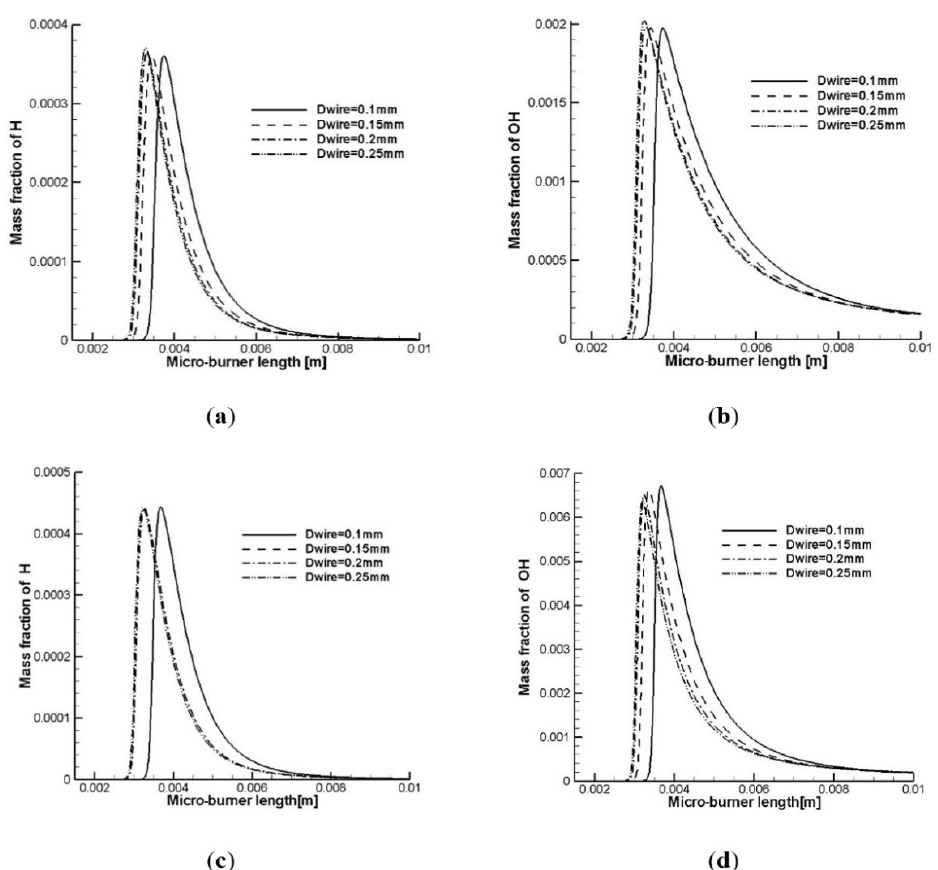
Figure 5. Flux analysis of methane consumption (20%) at three different temperatures corresponding to the axial distance where CH 3 mass fraction starts to rise: (Blue) 1330 K (D wire : 0.1 mm); (Red) 1420 K (D wire : 0.15 mm); (Black) 1430 K (D wire : 0.25 mm); “M” refers to a third body reaction.